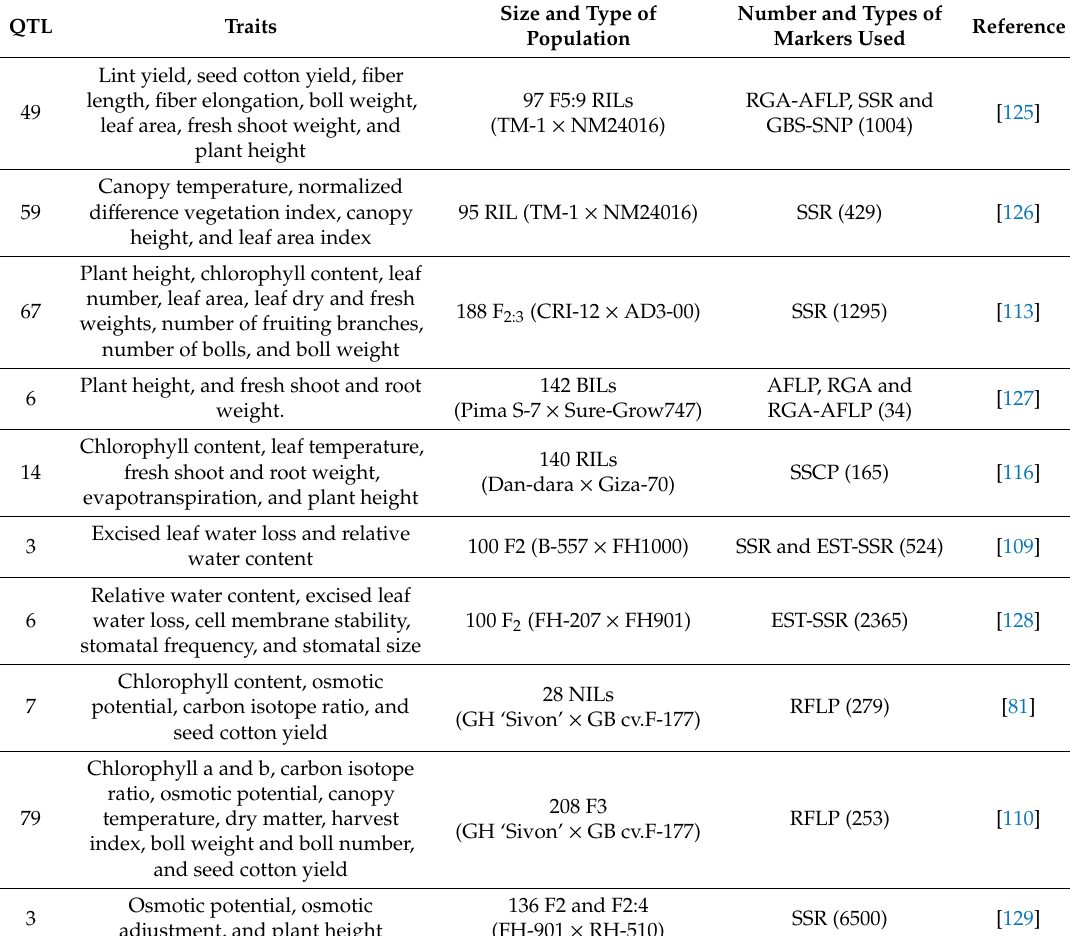
Table 2. Quantitative trait loci (QTLs) of drought tolerance in